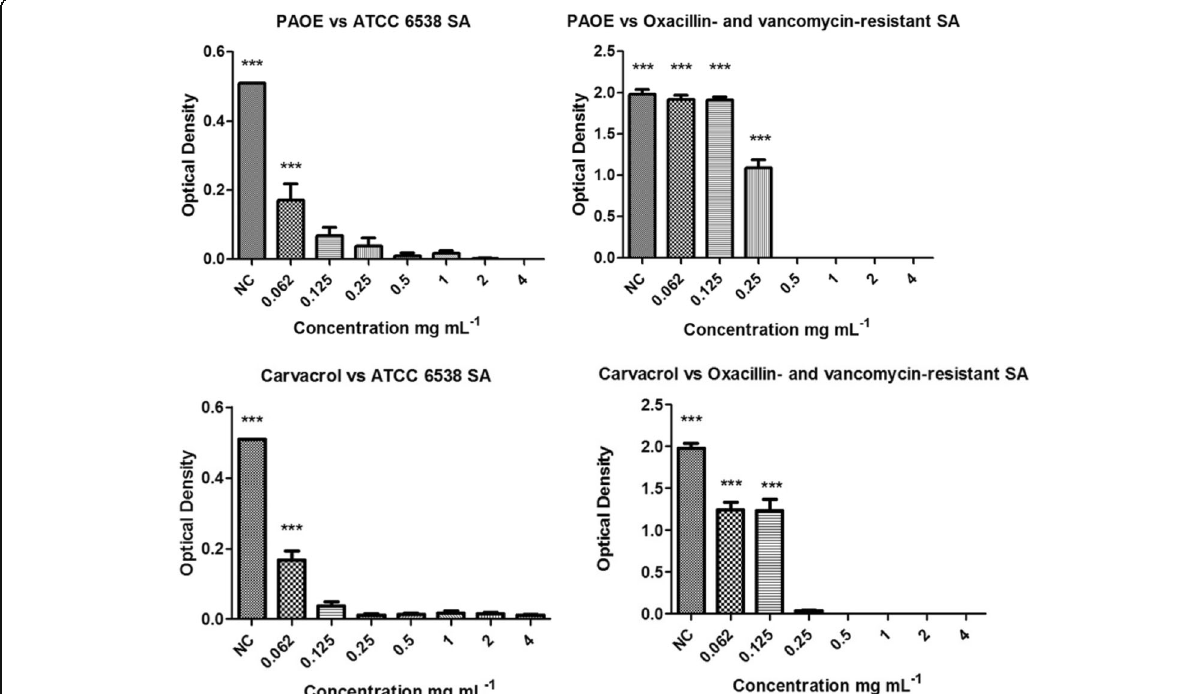
Fig. 3 Optical density of bacterial biofilm in S. aureus ATCC 6538 and S. aureus isolated from food, treated with OEPA and carvacrol in varying concentrations (0.062, 0.125, 0.25, 0.5, 1, 2 and 4 mg mL − 1 ). ANOVA, followed by Student-Newman-Keulstest *** p < 0.001 vs. all variables.*SA: Staphylococcus aureus . NC: negative